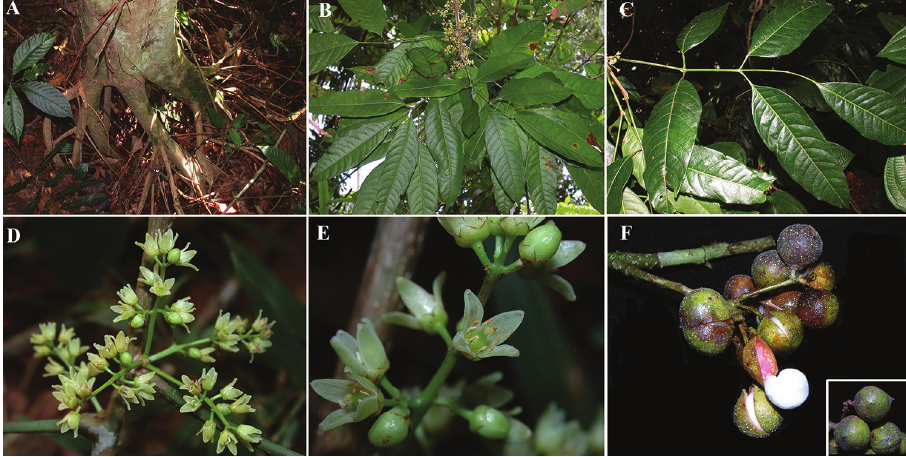
Figure 5. Protium hammelii . A Stilt roots B Branch with inflorescences C Adaxial side of the leaflets D Inflorescences E Flower F Fruits. Photo credits: Orlando Vargas ( A–E ); and N. Zamora ( F